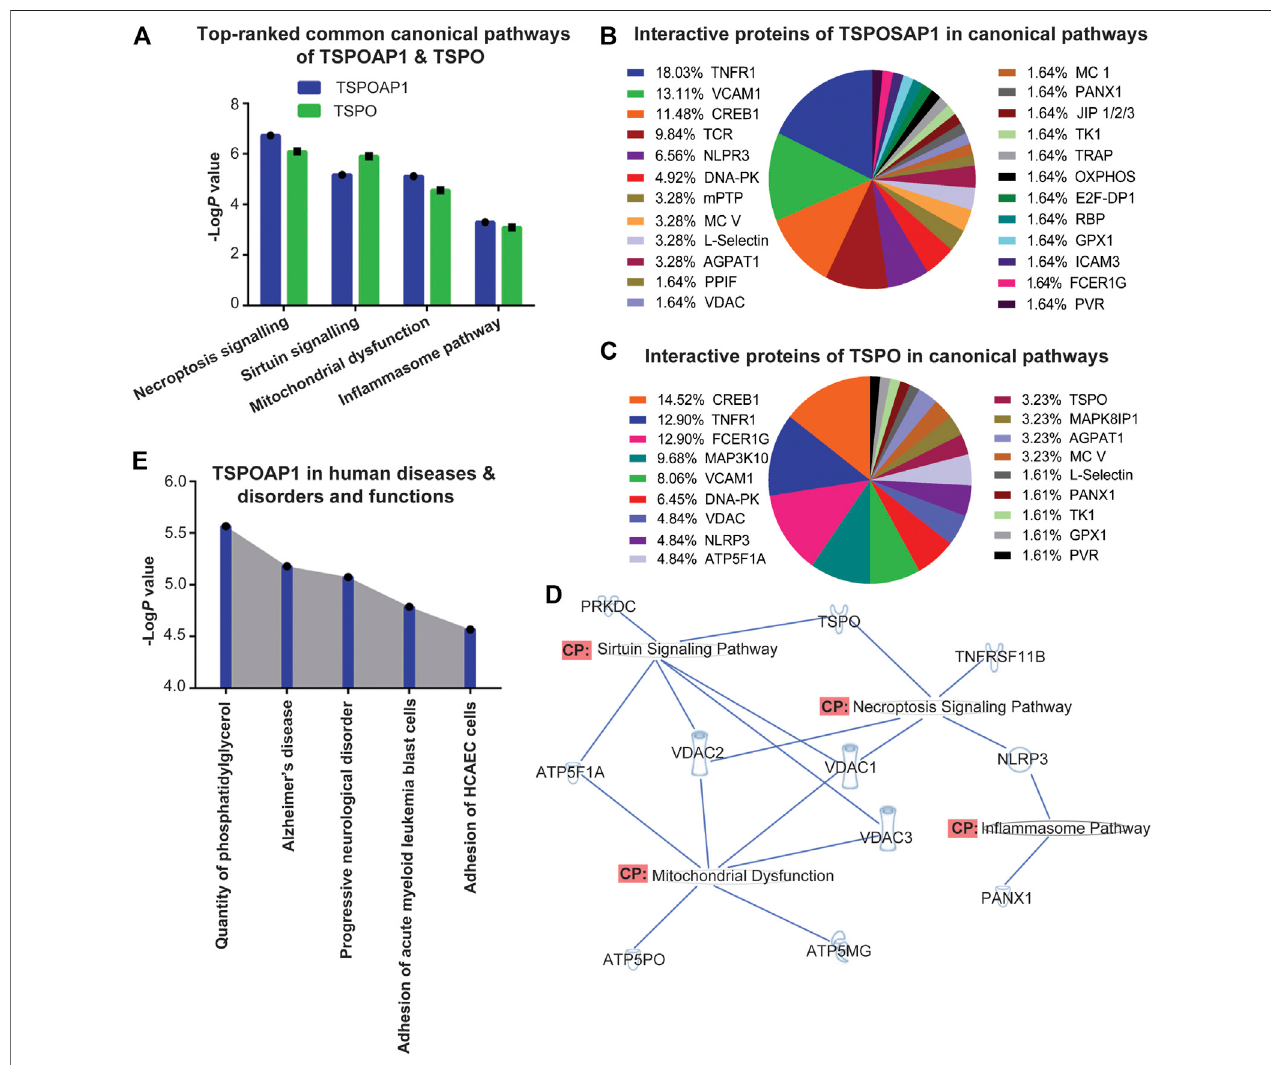
FIGURE2|(A) Top-ranked common canonical pathways ofTSPOAP1and TSPO. (B) Interaction partnersofTSPOAP1 inthecanonical pathways. (C )Interaction partnersofTSPOinthecanonicalpathways. (D) Overlappingoftop-rankedcanonicalpathwaysofTSPOAP1,highlightingthecommonenzymes,proteins,andgenesin these signalling pathways. (E) Top- fi ve human diseases and disorders and functions associated with TSPOAP1. Symbols in Figure 2D : TSPO and TNFRSF11B; transmembrane receptor, VDAC 1/2/3; ion channel, NLRP3; complex/group/other, ATP5PO, ATP5F1A, and PANX1; transporter, ATP5MG; enzyme, PRKDC;